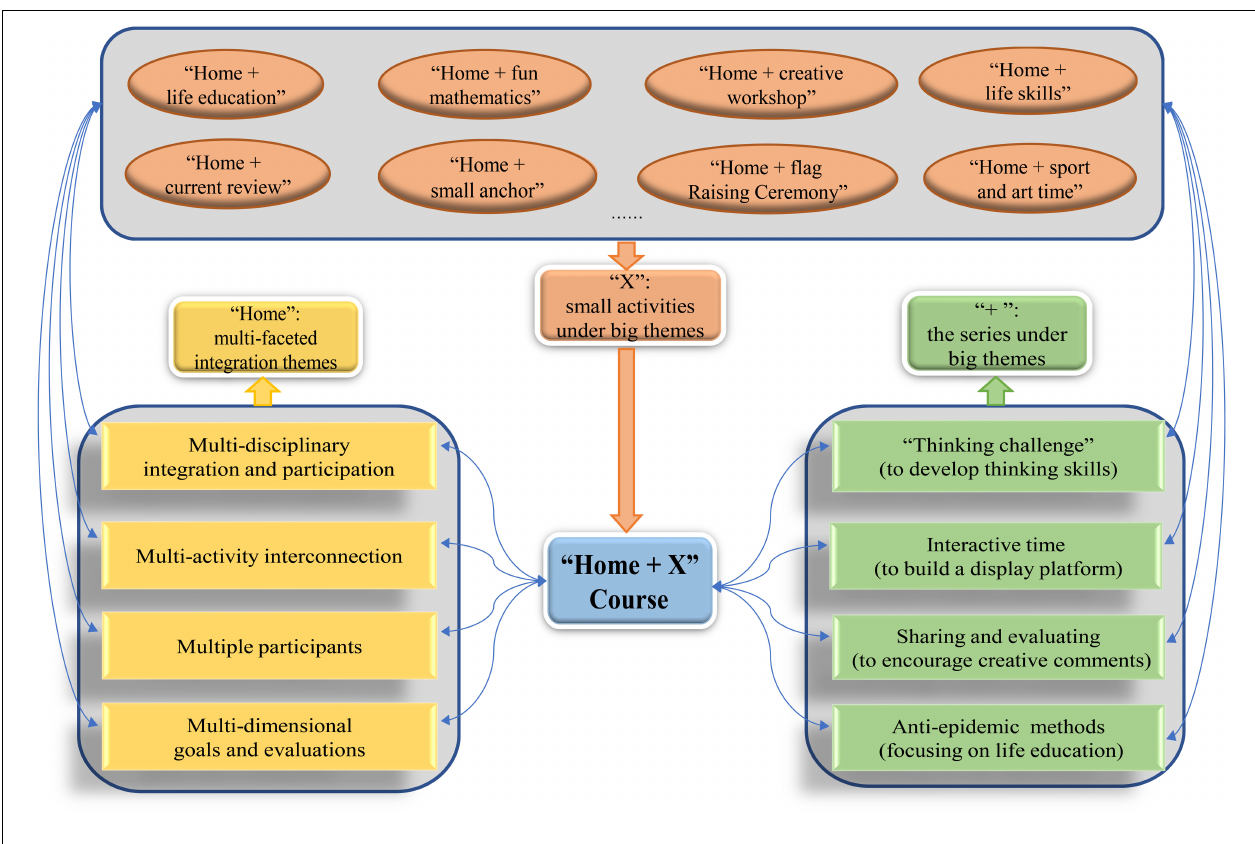
FIGURE 2 | The framework of the “Home + X” course. TABLE 1 | “Home + life education” theme series activities